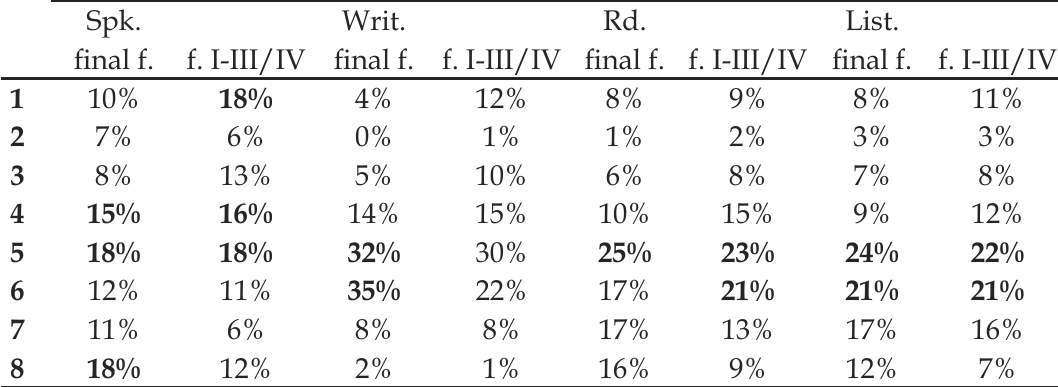
Table 3. Frequency of summative assessment provision in the case of FL skills Spk. Writ. Rd. List.